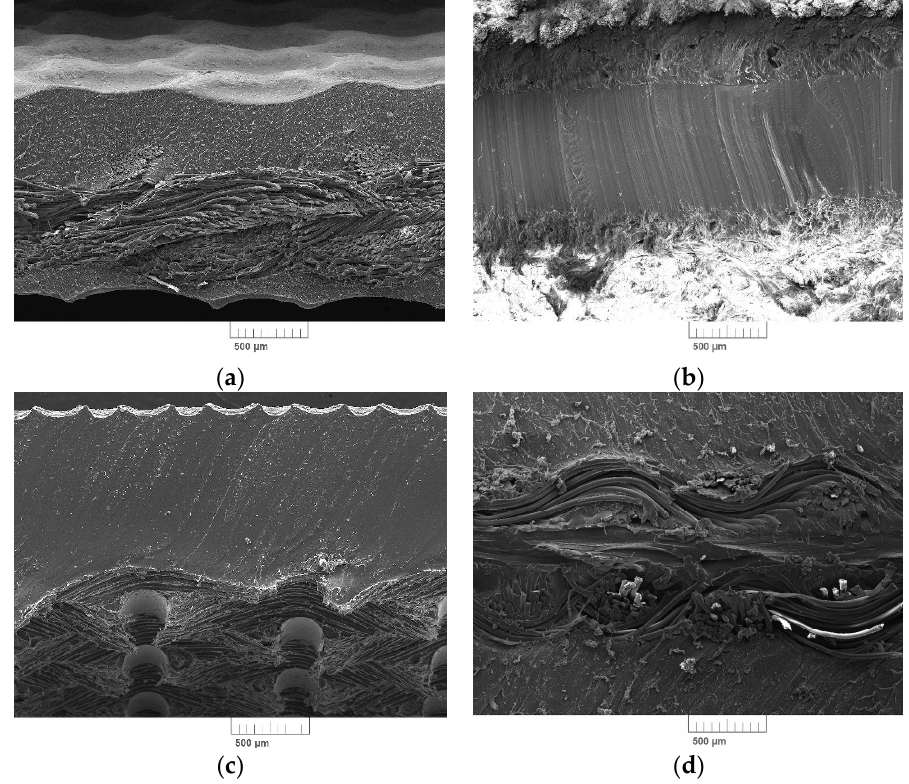
Figure 2. SEM pictures of flat belts: ( a ) NE22, ( b ) LL2, ( c ) TC, and ( d ) XH.